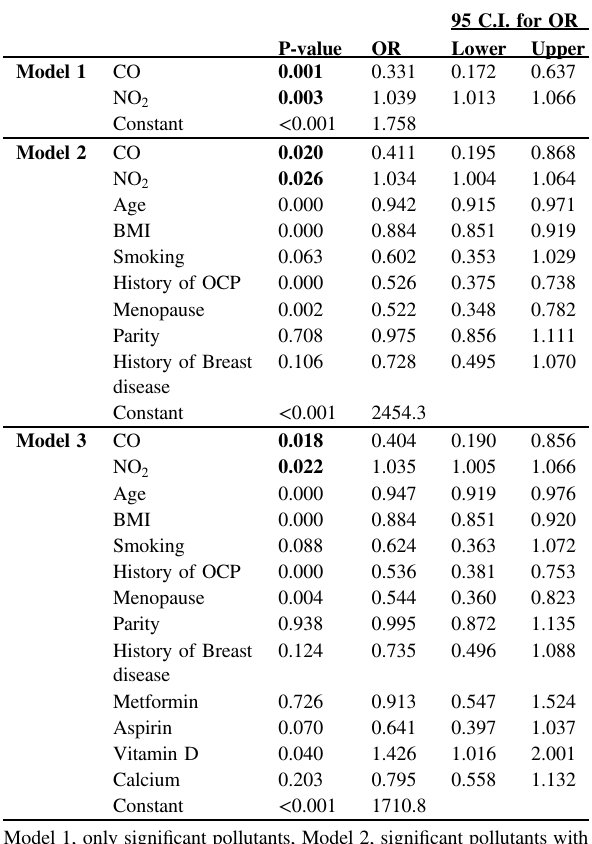
Table 3 Logistic regression models for ambient air pollutants im- pact on mammographic breast density considering confounder